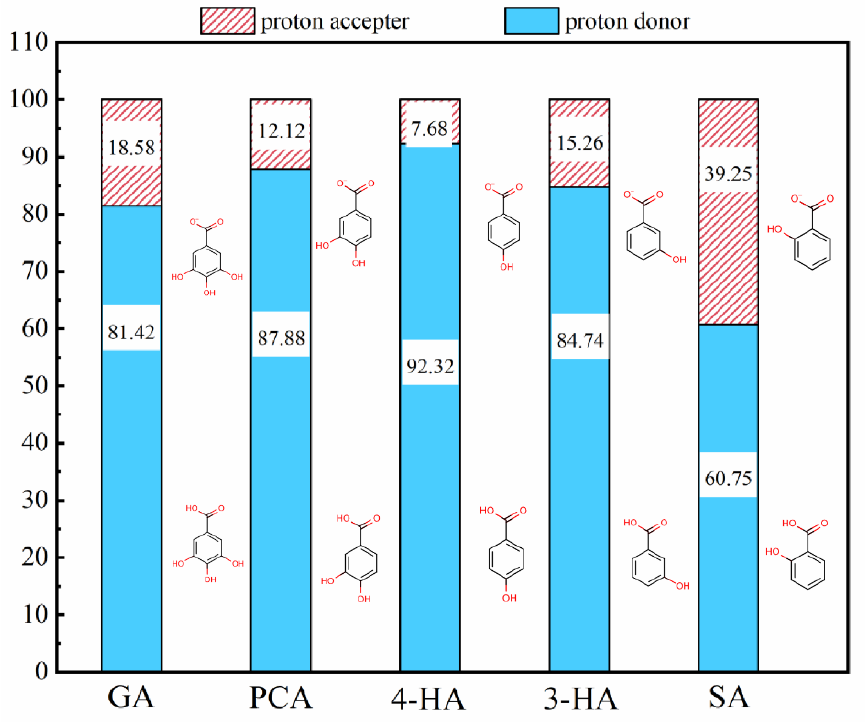
Figure 1. The dissociation percentages of the five phenolic acids at original pH.